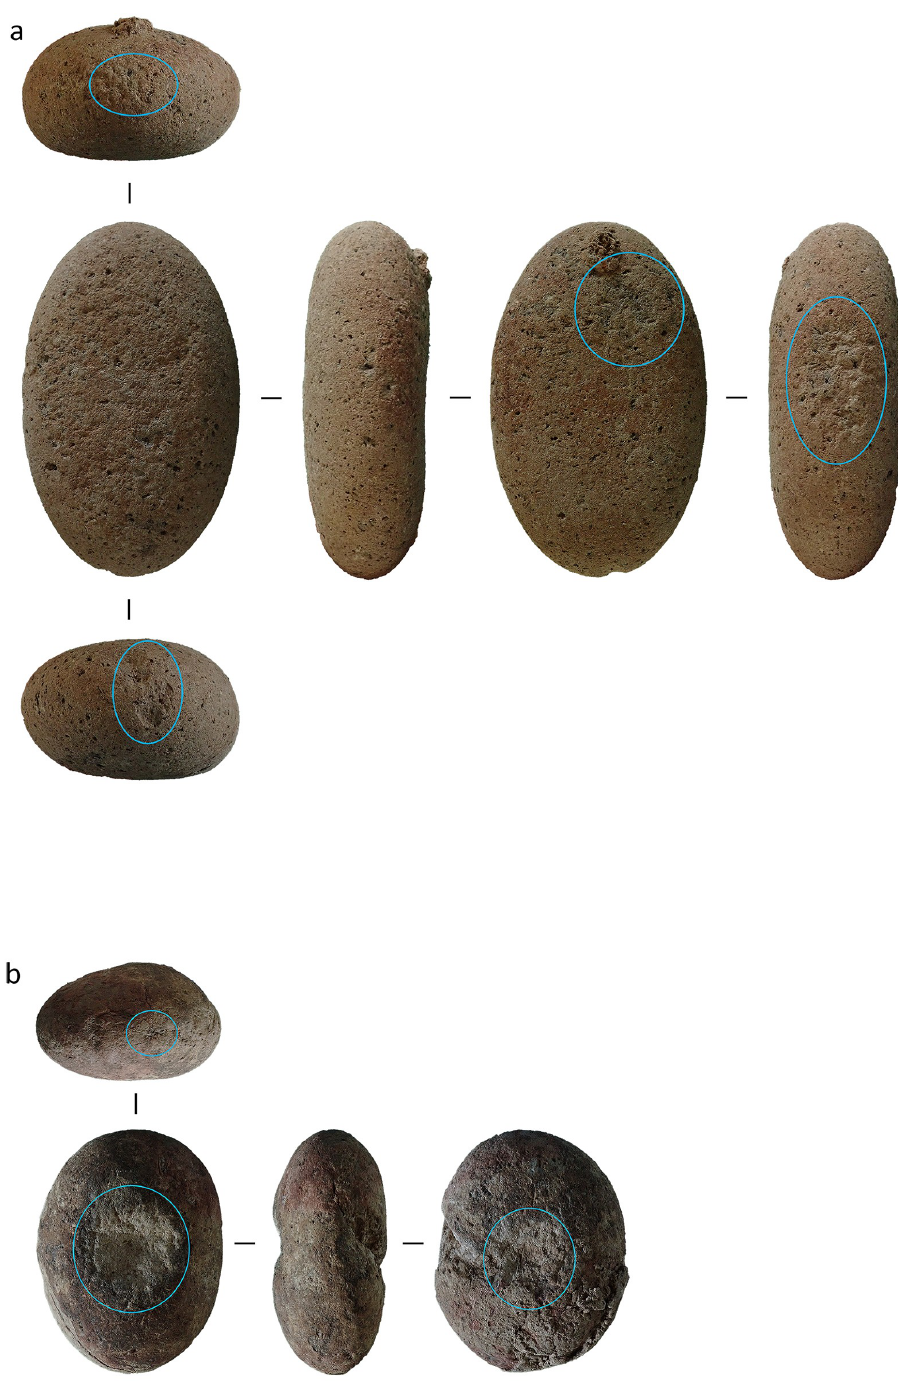
Fig 4. Anvils and hammerstones from Leang Pajae, Test Pit 1. The battered areas on these river cobbles are circled in blue. (a) Cobble recovered 0–10 cm below the surface, within Layer 1. (b) Cobble recovered 50–60 cm below the surface, Layer 3. Associated finds suggest these are Toalean deposits [unpublished], though (a) originates from a layer which includes mixed Neolithic finds. These two artefacts are more likely to be associated with bipolar reduction than nut or seed processing [105]. Scale bar = 5